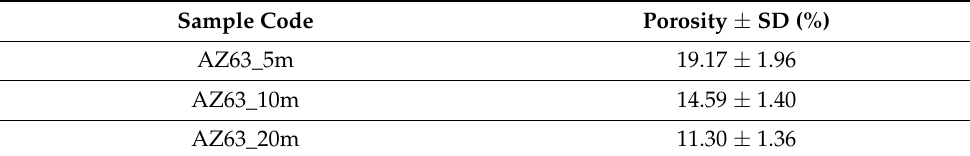
Table 1. Mean porosity values of the PEO treated surfaces.